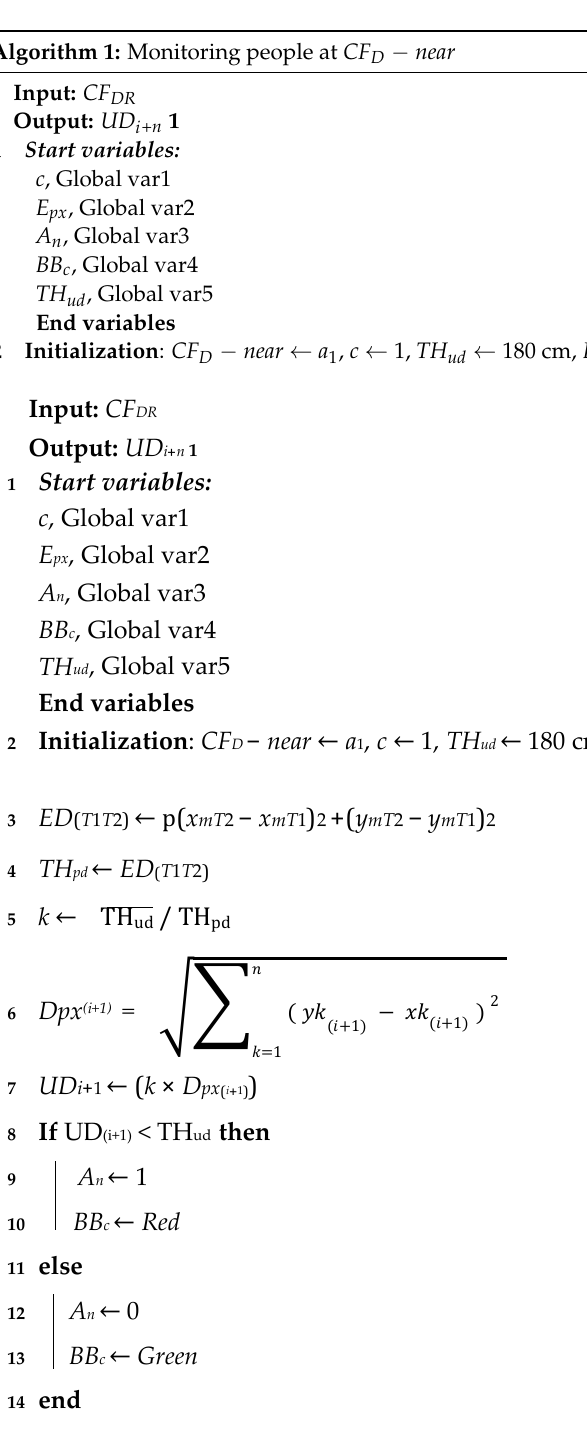
Algorithm 1: Monitoring people at CF D − near